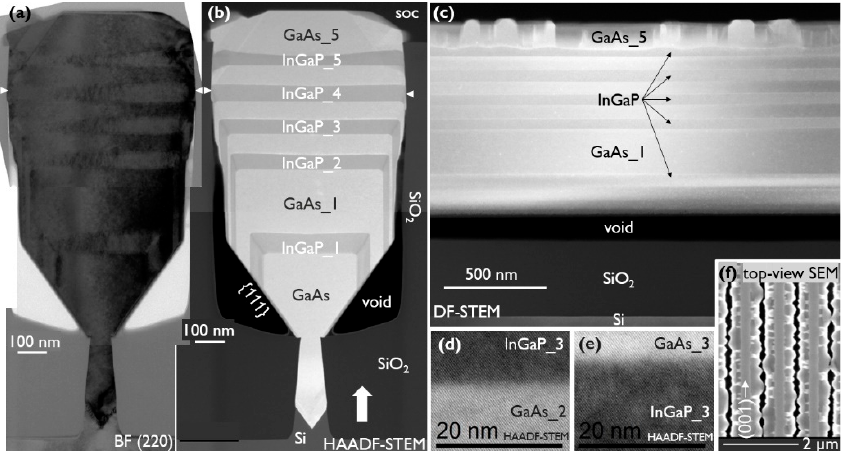
Figure 5. TEM of a 5 × GaAs/InGaP multilayer stack cut across the trench under ( a ) two-beam BF (220) and ( b , d , e ) HAADF-STEM and ( c ) of an off-center cut (at broad white arrow in ( b )) along the trench under DF-STEM. The full NR images ( a , b ) are stitched. High-resolution images of the third InGaP layer’s interfaces are shown in ( d , e ). ( f ) Top-view SEM of NRs with defectivity at the NR sides and the pristine (001) top facet present in between.